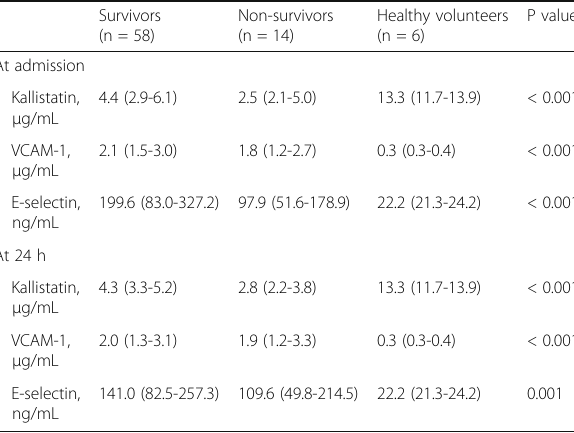
Table 1 (abstract 0119). Serum levels of kallistatin, VCAM-1, and E- selectin among 28-day survivors, non-survivors, and healthy volunteers